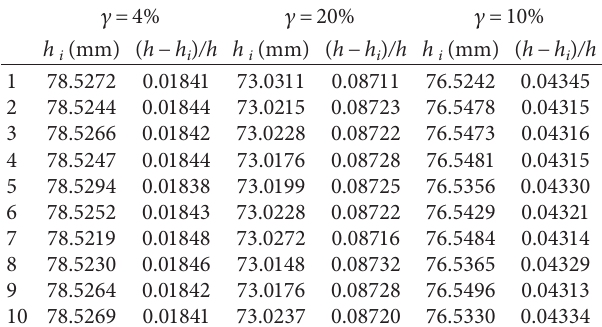
Table 4: Calculation results of h i based on IPSO calculation results. c � 4% c � 20% c �